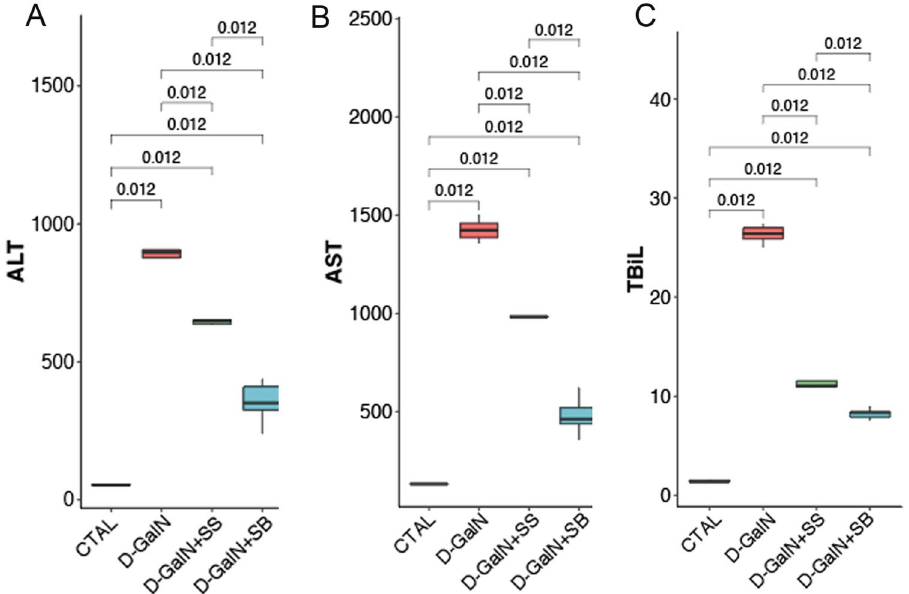
Figure 1. Effects of fecal microbiota transplantation (FMT) on ( A ) ALT, ( B ) AST, and ( C ) TBIL